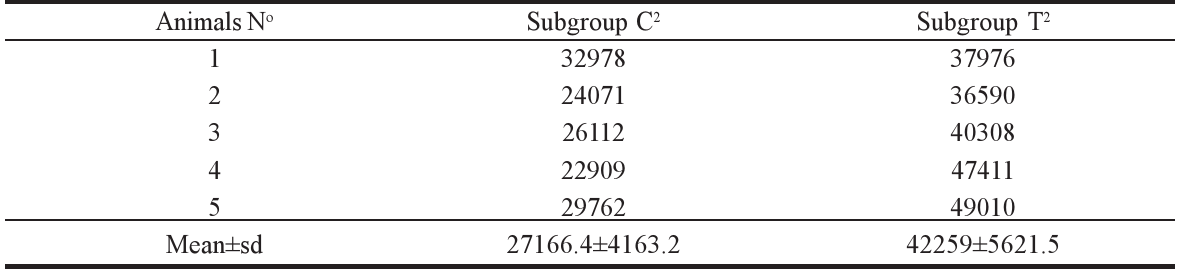
TABLE 2 - Histopathologic mean density on the subgroups C 2 and T 2 , observed during seven days.